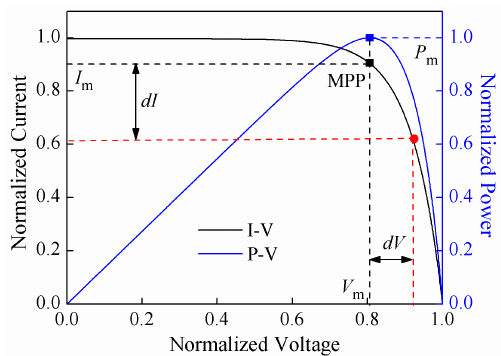
Figure 3. I-V and P-V curves of a PV cell